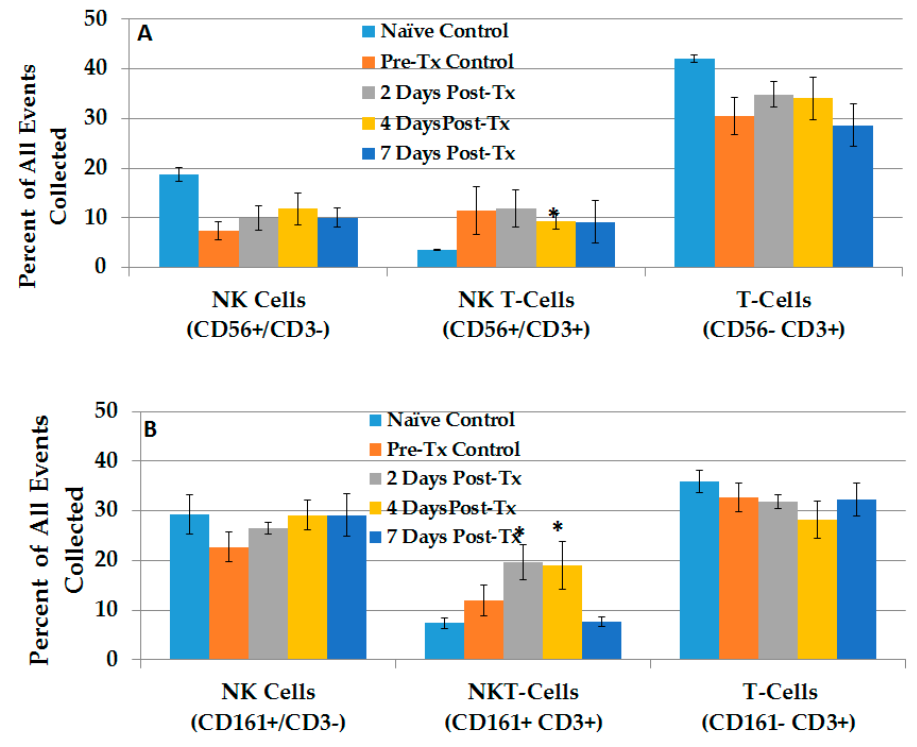
Figure 5. Differential analysis of natural killer cells with CD56 or CD161 as the defining marker. Lymphocytes were isolated from rat livers (tumor bearing lobe) at various times post-Tx. Cells were stained with CD56, CD161, CD3, CD8a and CD314-NKG2D. Analyses were done on CD56+/CD3 − cells ( A ) CD161+/CD3 − ( B ). Error bars = standard error of the mean (SEM); Naïve n = 4, Pre-Tx n = 5; others n = 6. * p < 0.05.